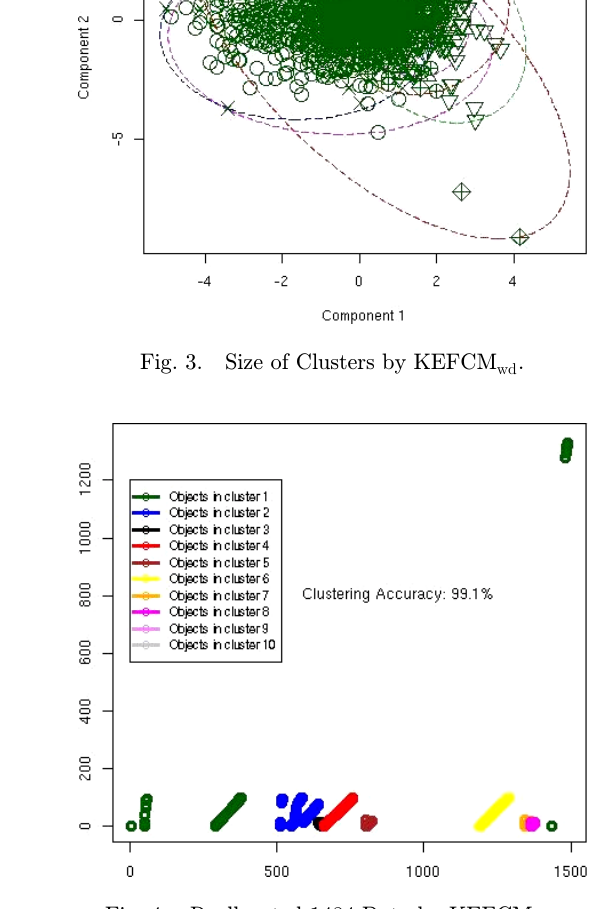
Fig. 4. Reallocated 1484 Data by KEFCM wd .